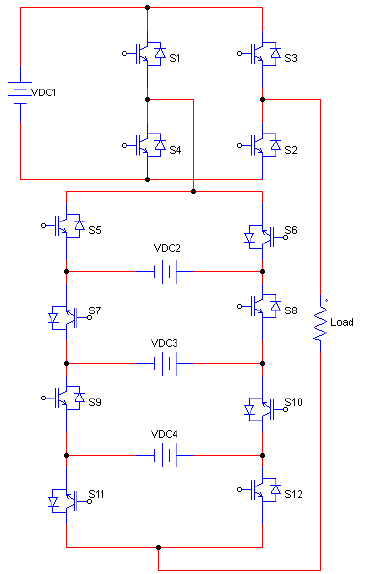
Figure 11. Equivalent circuit for full bridge MLI for 21 levels of output.